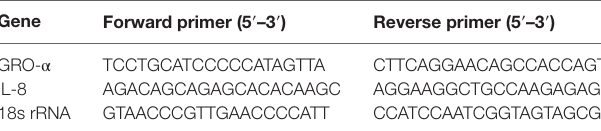
TaBle 1 | List of primers used for quantitative real-time PCR. gene Forward primer (5 ′ –3 ′